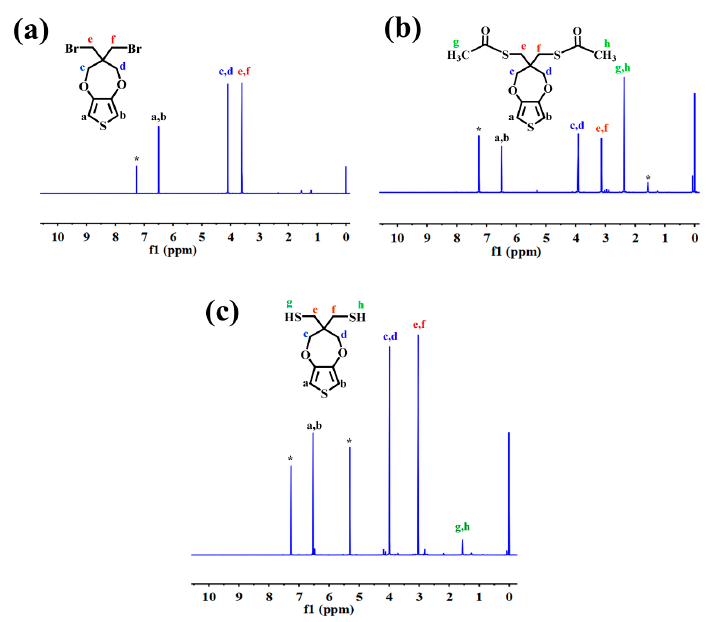
Figure 1. 1 H NMR spectra of ProDOT(MeSH) 2 in CDCl 3.